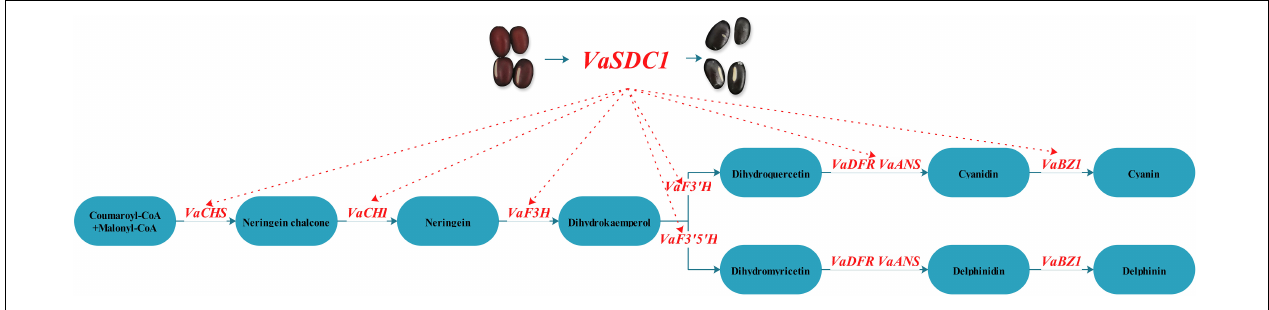
FIGURE 6 | Hypothetical model of the molecular mechanism of the flavonoid metabolic pathway in the red Jingnong6 and the black AG118.